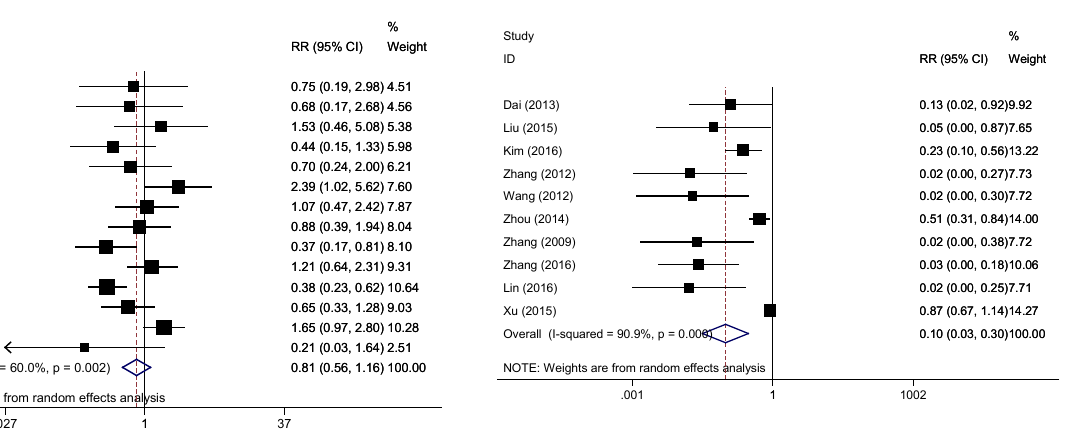
Figure 2: Forest of ORR of Pemetrexed versus Gefitinib as second- line treatment for advanced NSCLC.